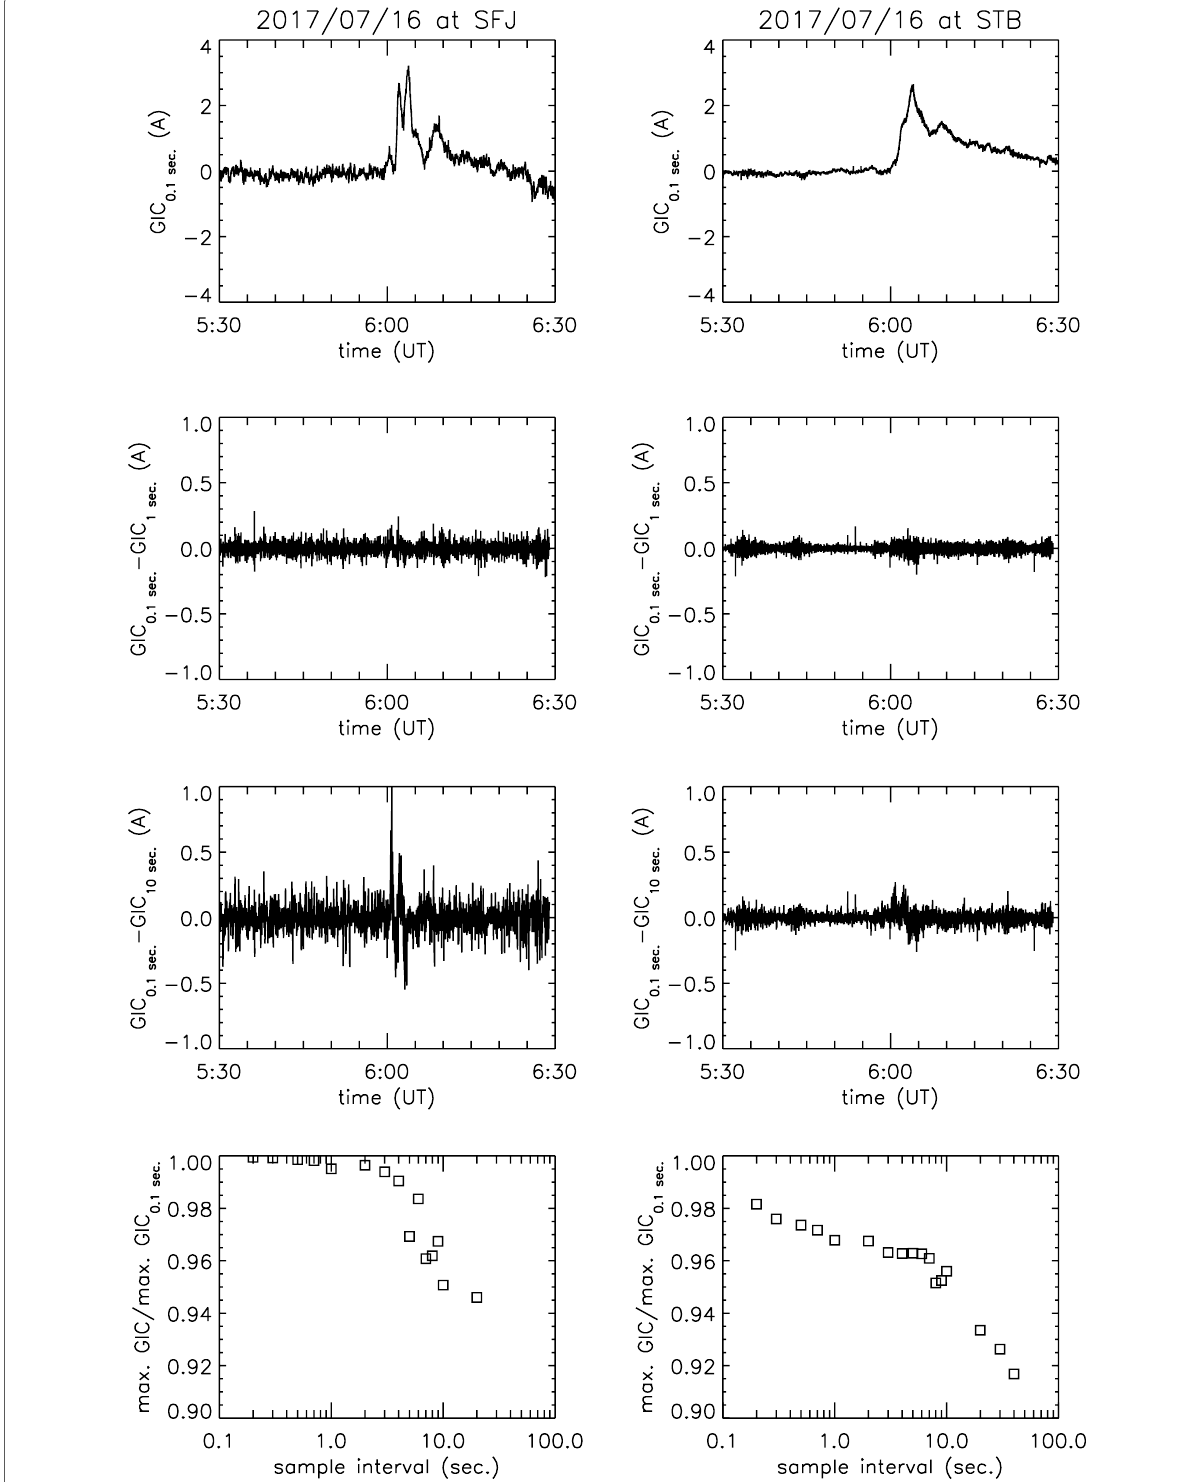
Fig. 6 GIC at SFJ and STB associated with the 16 July 2017 SSC. The top panel shows the raw GIC data with 0.1-s sampling. The second- and third-row panels show the differences between data sampled every 0.1 s and the 1-s resampled data and the differences between the data sampled every 0.1 s and the 10-s resampled data, respectively. The bottom panels show the ratio of the maximum GIC of the resampled data for the given sample interval to that of the 0.1-s sampled data as a function of the sample